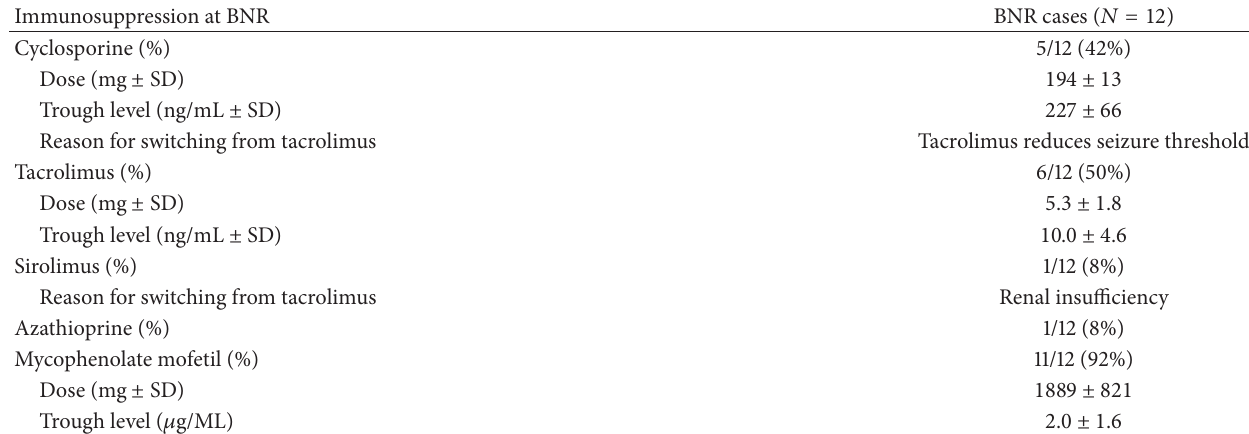
Table 2: Immunosuppression at BNR